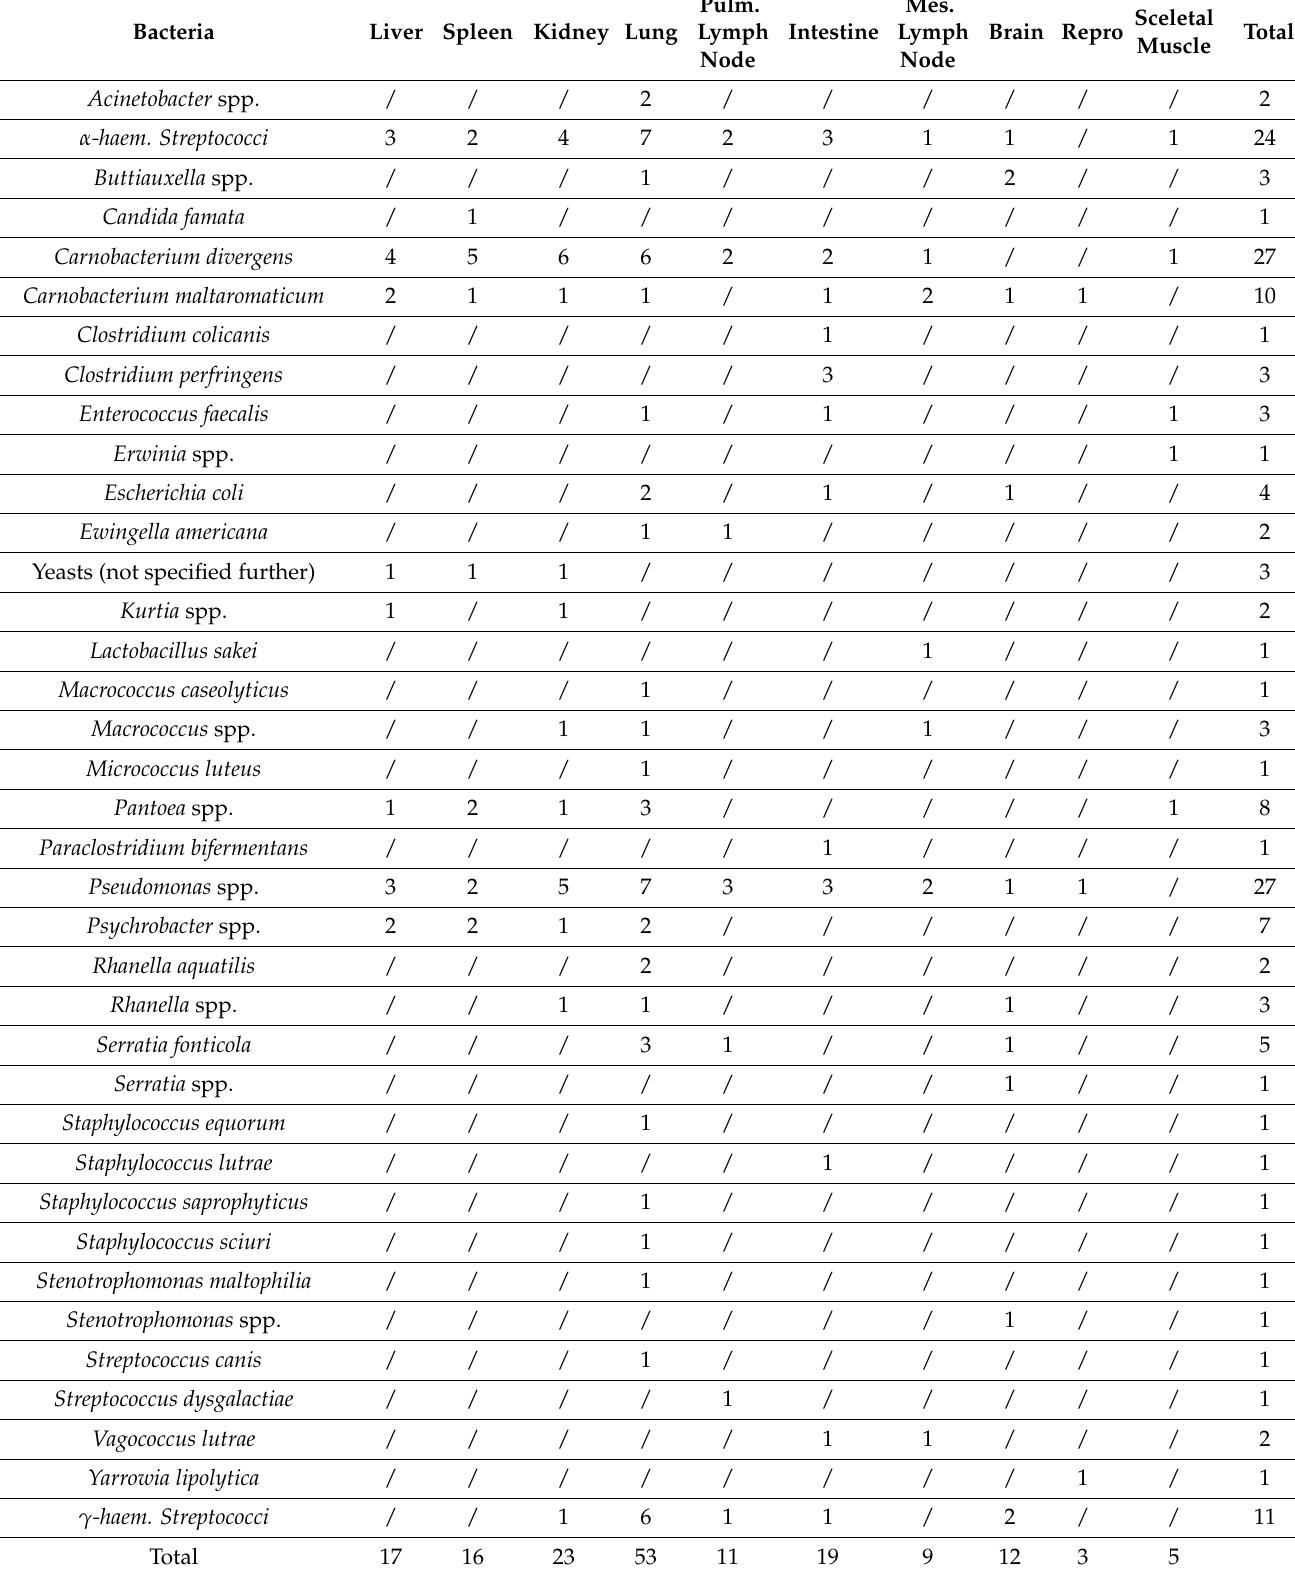
Table 4. Microbiological results from the otters found dead in Schleswig-Holstein between 2015–2020.